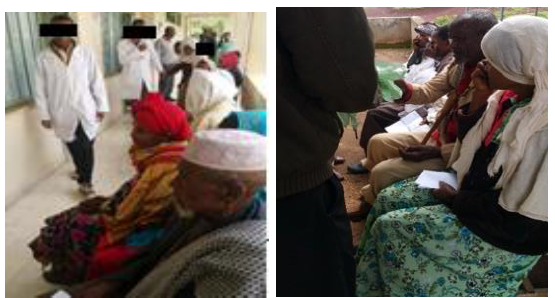
Figure 5. Outreach mission at Saja Primary Hospital. Patients waiting for screening(Left). Patients waiting to go through cataract